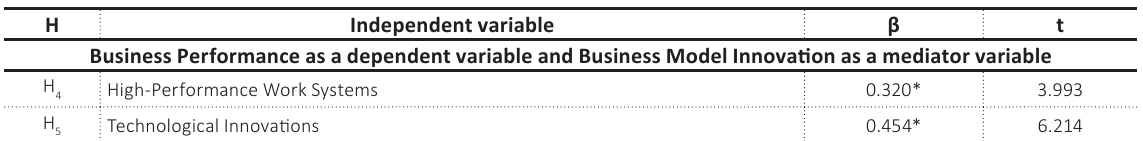
Table 7. Indirect effects in the path analysis ( n =